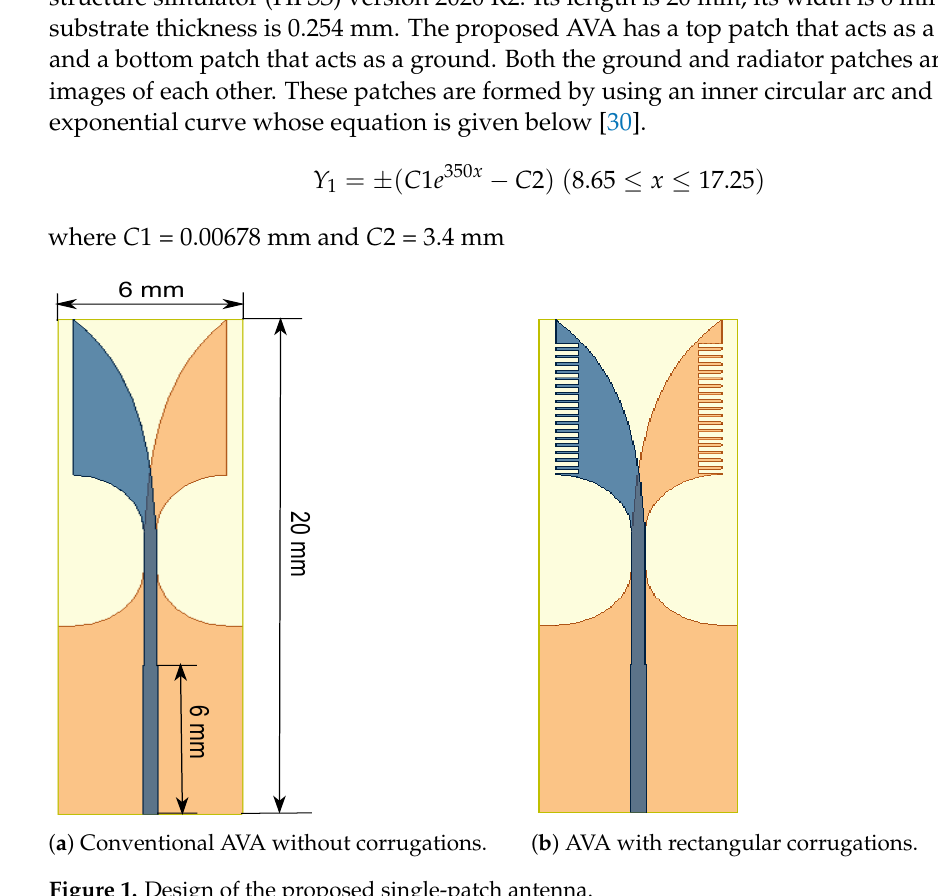
Figure 1. Design of the proposed single-patch